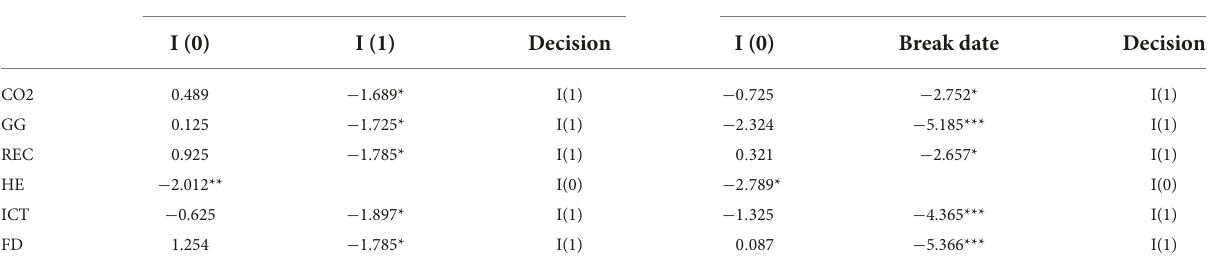
TABLE 3 Unit root test results.